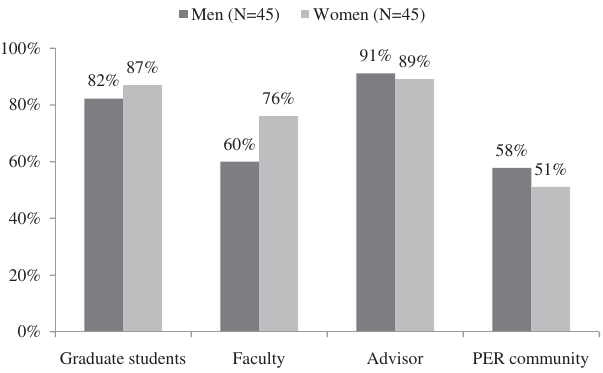
FIG. 5. Where students want to be working in ten years.